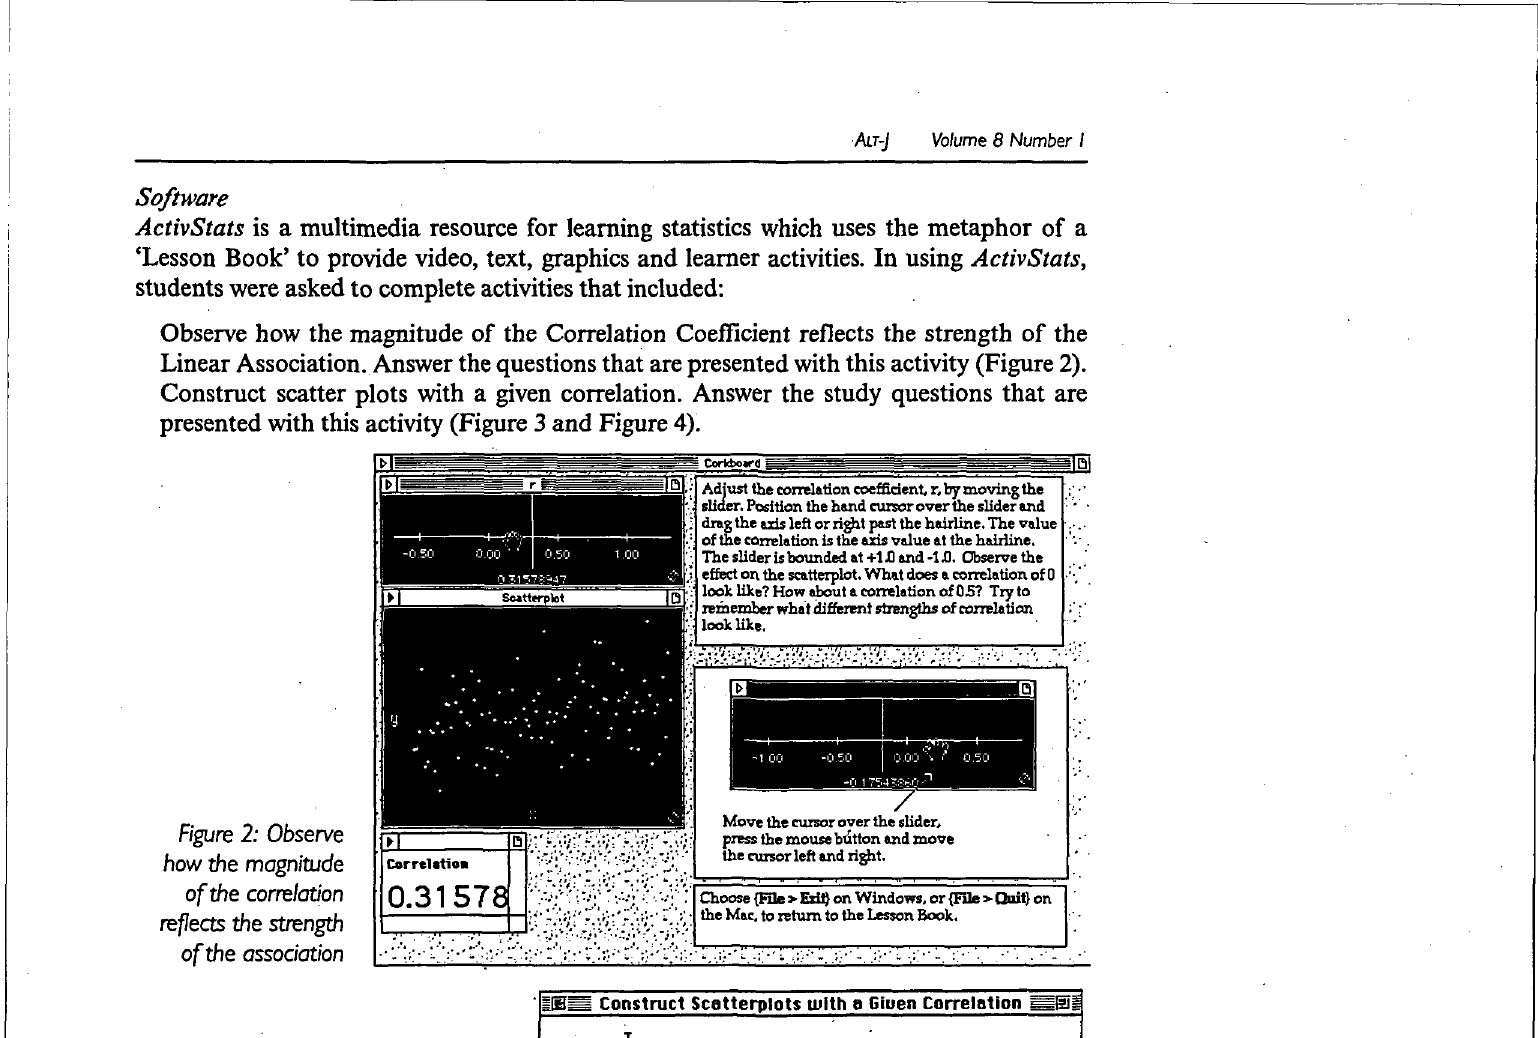
figure 2: Observe how the magnitude of the correlation reflects the strength of the association